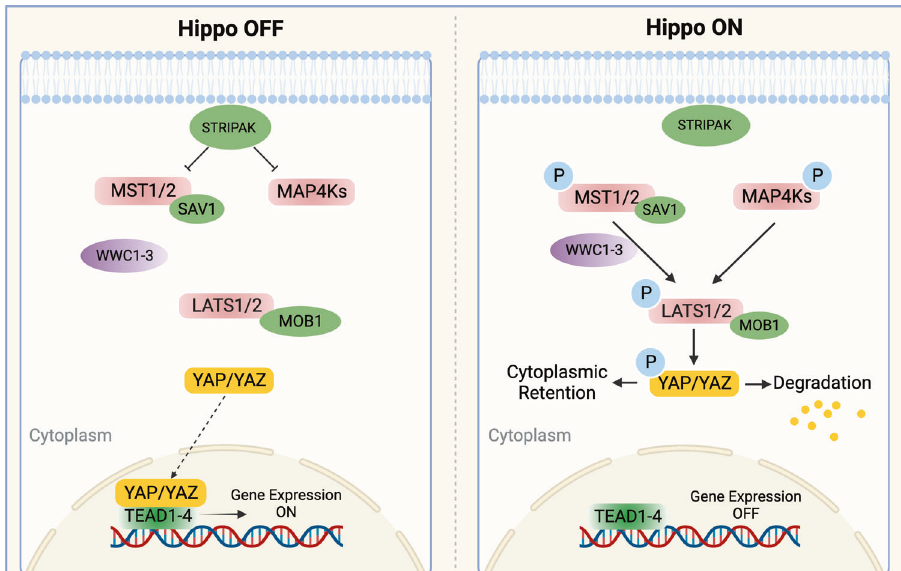
Fig. 2 The core Hippo pathway in mammals. STRIPAK complex in the upstream regulates both MST1/2 and MAP4Ks. MAP4Ks or MST1/2 and its scaffold protein SAV1 could phosphorylate LATS1/2 and its scaffold MOB1 with the help of WWC1 – 3. The phosphorylated MOB1 can also directly promote the activation of LATS1/2 by inducing the conformational change of LATS1/2. The activated LATS1/2 phosphorylated and inactivated YAP/TAZ, preventing it from translocating into the nucleus and binding to transcription factors TEAD1 –